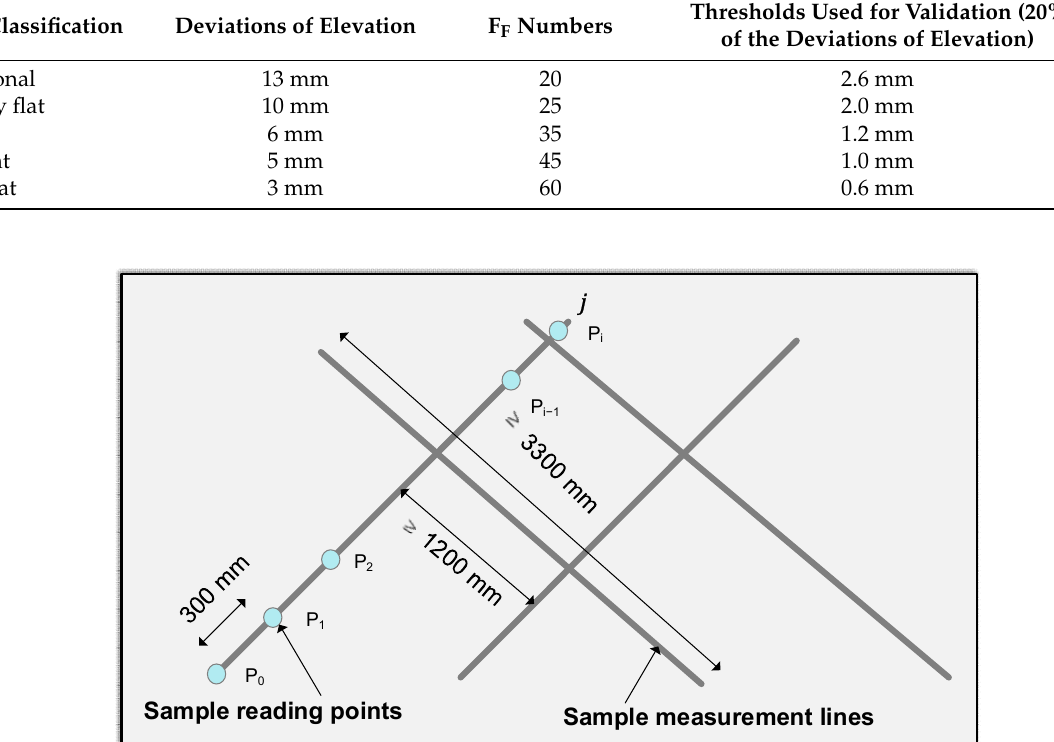
Figure 2. Illustration of determining F F numbers on a slab.